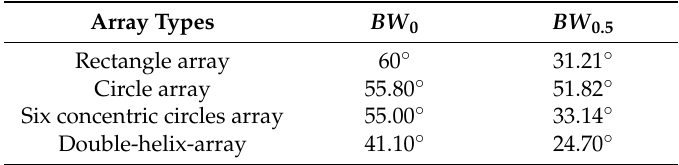
Table 1. Beam widths at zero point ( BW 0 ) and half-power point ( BW 0.5